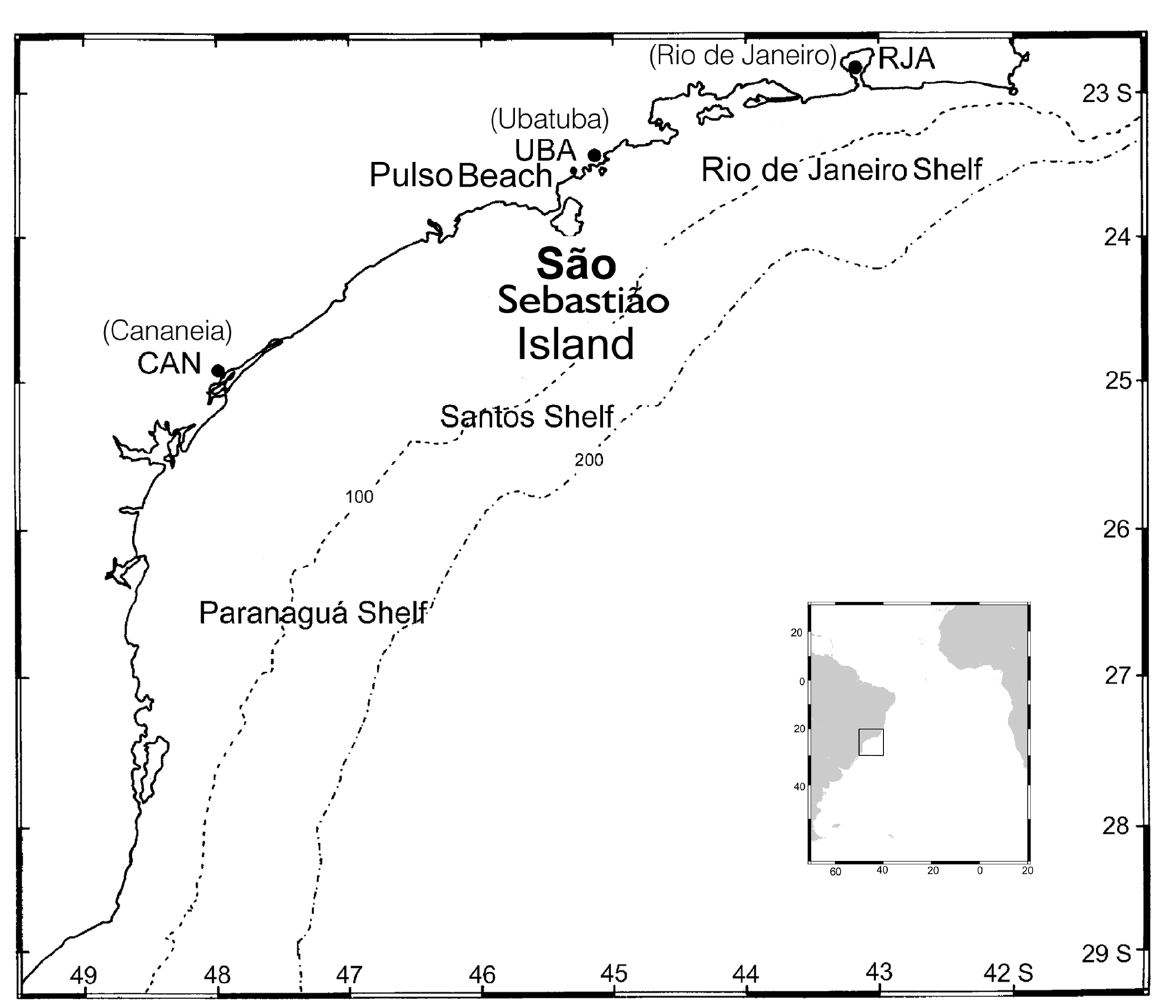
Fig. 1 – View of the South Eastern Brazilian Shelf showing the positioning of the Island of São Sebastião and the city of Ubatuba, between which, the measurements at “Praia do Pulso” (PP), have been